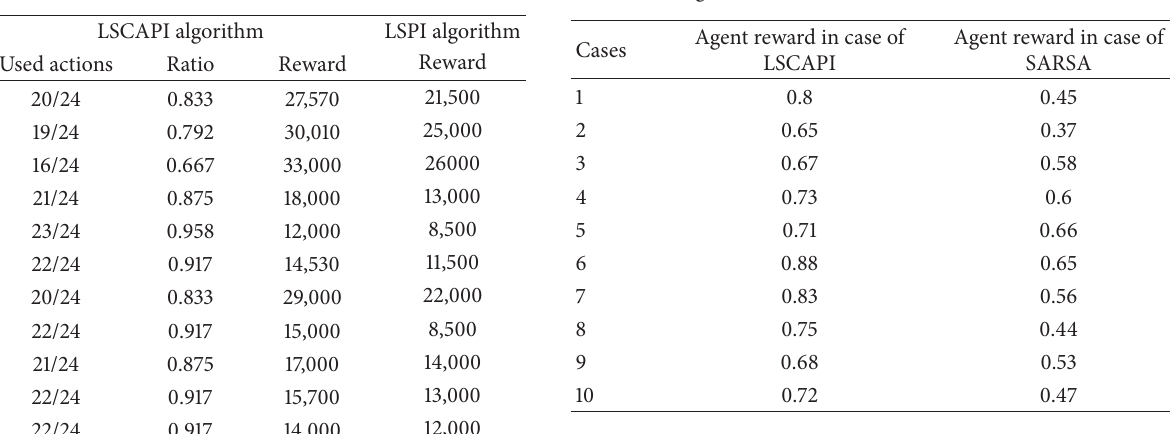
Table 10: Agent reward calculations of LSCAPI versus